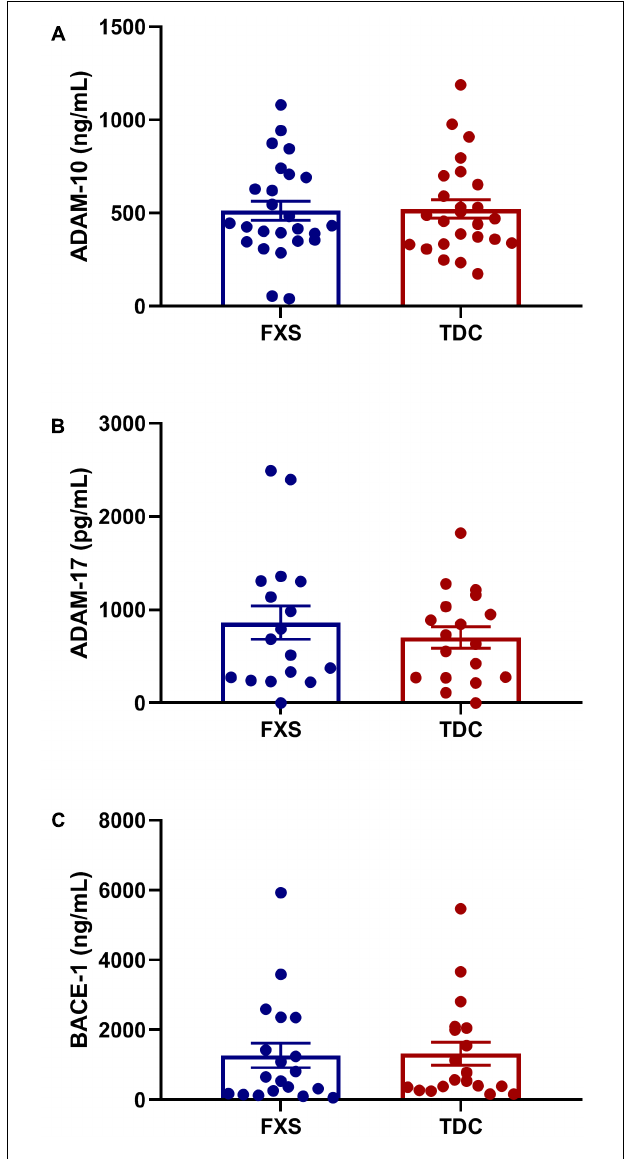
FIGURE 2 | Plasma levels of APP processing enzymes in FXS and control subjects. Plasma levels ADAM-10, ADAM-17, and BACE-1 were measured using ELISA in both FXS and TDC subjects. Outliers determined by the ROUT method were excluded from analysis [BACE-1 (FXS = 3, TDC = 1)